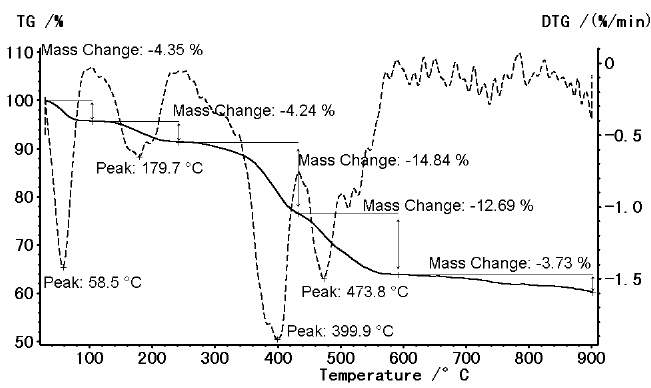
Figure 3. TG and DTG analysis for compound ( 1 ).